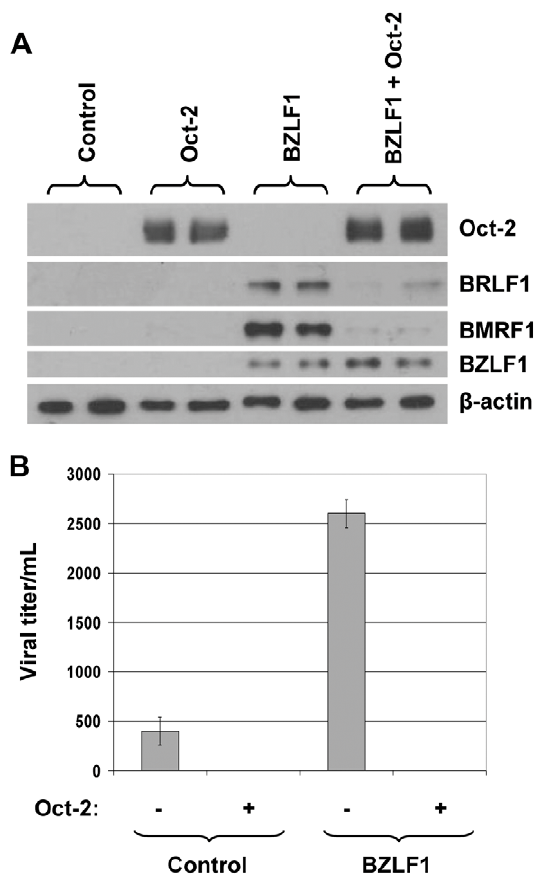
Figure 2. Oct-2 inhibits lytic EBV replication. (A) CNE-2 Akata cells were transfected with 5 ng BZLF1, 500 ng Oct-2, or control expression vectors as indicated. Immunoblot analysis was performed to compare the levels of transfected Oct-2 and BZLF1, as well as the lytic viral proteins BMRF1 and BRLF1 derived from the endogenous viral genome. b -actin expression was used as a loading control. (B) The amount of infectious virus produced by each condition in Figure 2A was determined using the green Raji cell assay as described in the Materials and Methods.